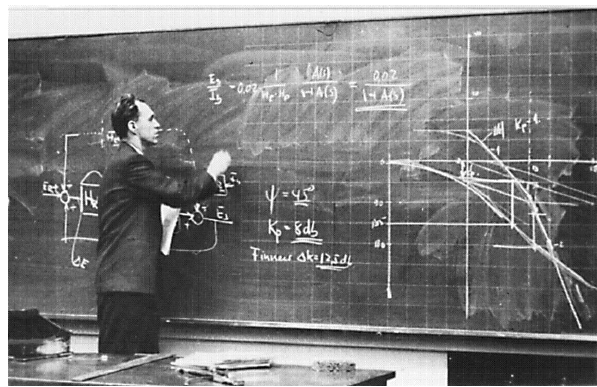
Figure 4: Associate professor (dosent) Jens Glad Balchen lecturing on block diagrams, trans- fer functions and Bode plots in the